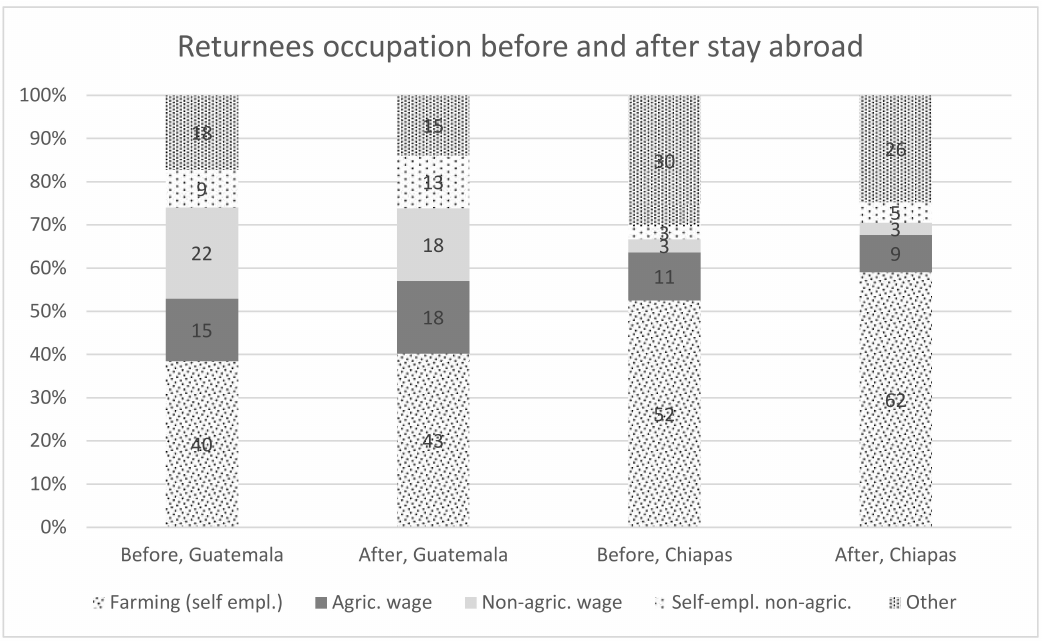
Figure 4. Occupation of returnees, before and after